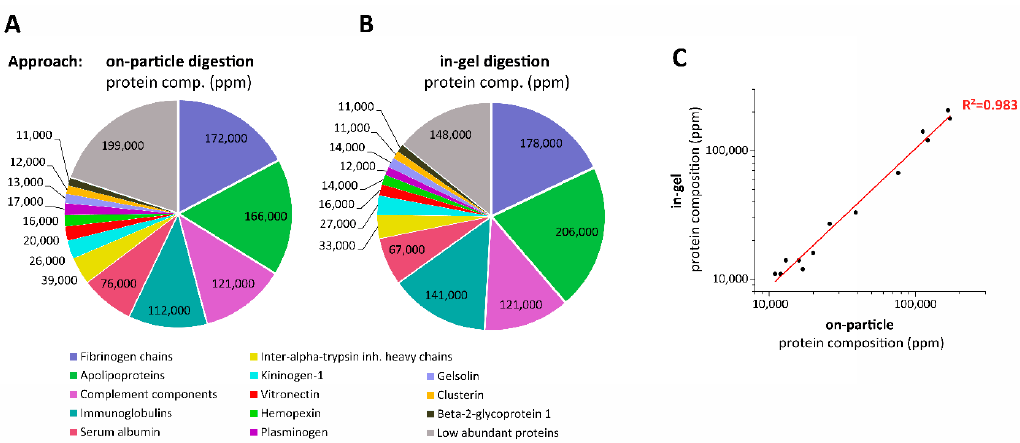
Figure 8. Protein composition in ppm from SiO 2 NM coronas as determined either by ( A ) on-particle digestion combined with CESI-MS analysis, or ( B ) in-gel digestion combined with CESI-MS analysis. ( C ) Relationship between protein compositions calculated for the most abundant proteins ( > 10,000 ppm) in both approaches.